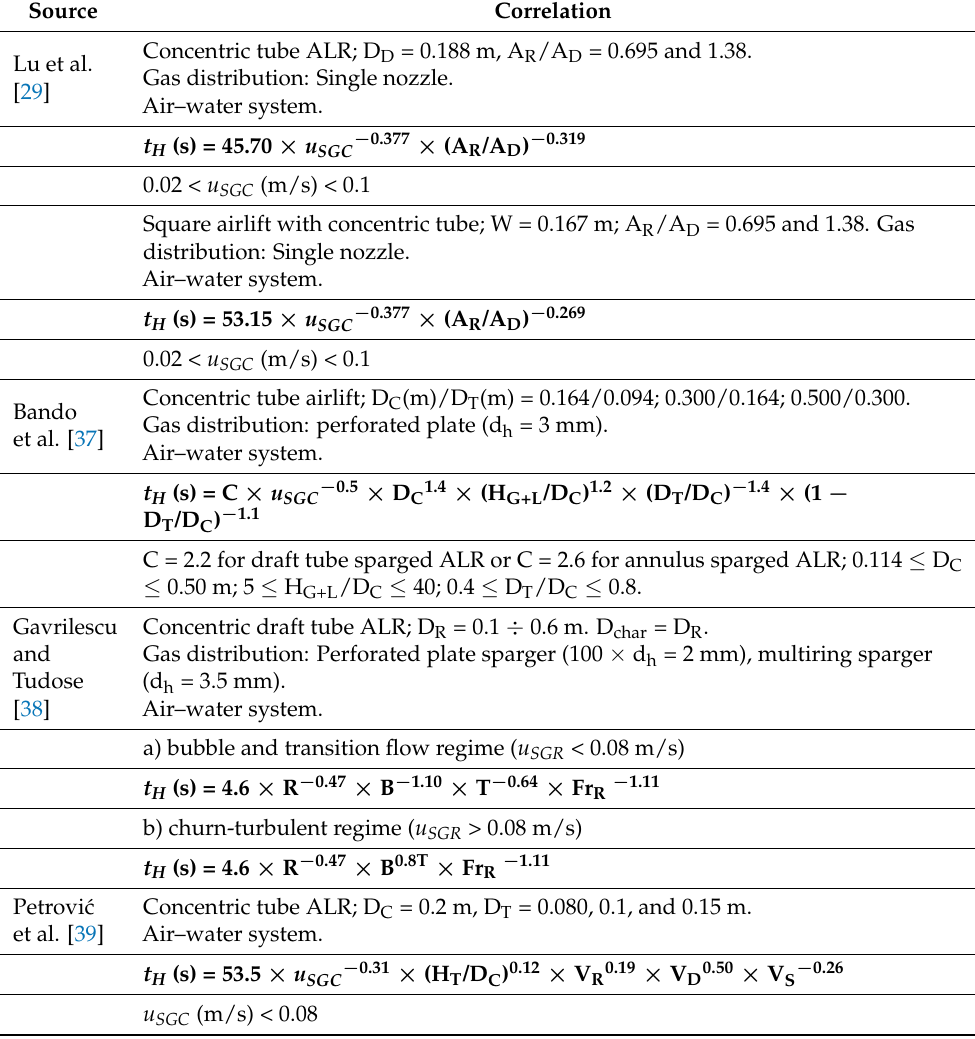
Table 3. Homogenization time t H —selected published correlations; adapted from